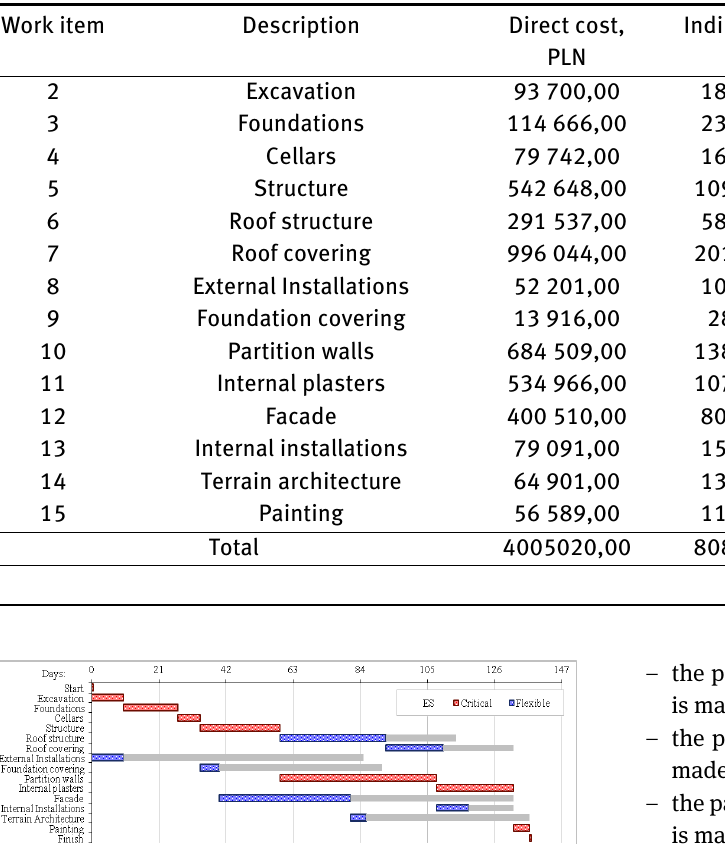
Table 2: Financial data for the bill of quantities contract.